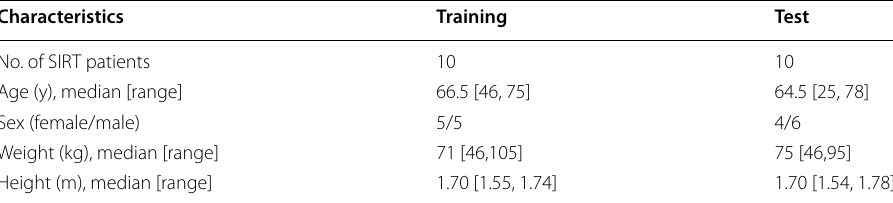
Table 1 Characteristics of the SIRT patients for registration experiment